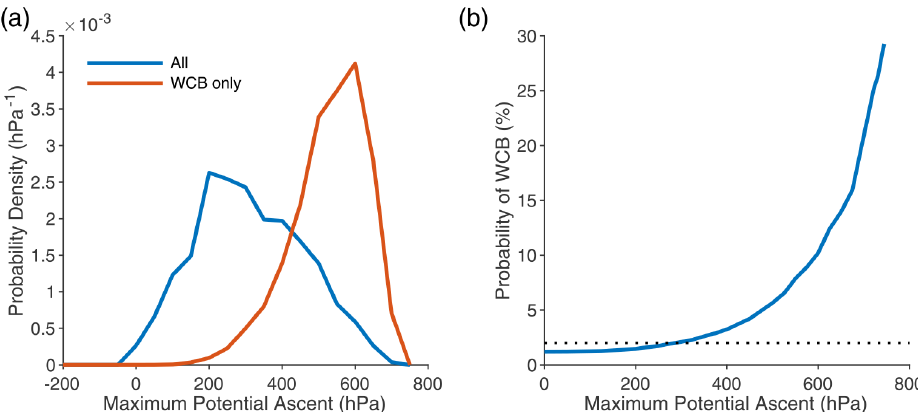
Figure 9. Statistical relation of WCB starting points to maximum potential ascent from daily local nonconvective MAPE calculations in the year 1985. (a) Probability density functions of the maximum potential ascent for all grid cells and days (blue) and for grid cells and days restricted to incidences of at least one WCB starting point (red). (b) Probability of at least one WCB starting point for grid cells and days above a given maximum potential ascent. For comparison, the probability of at least one WCB starting point for all days and grid cells in the extratropics (20–90 ◦ N and 20–90 ◦ S) is 2% (dotted line).